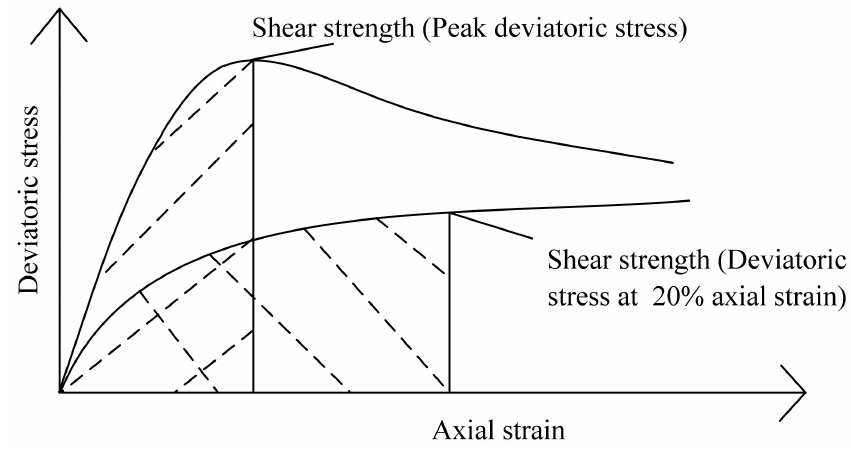
Figure 1. The shear or compressive strength determined by a triaxial compression